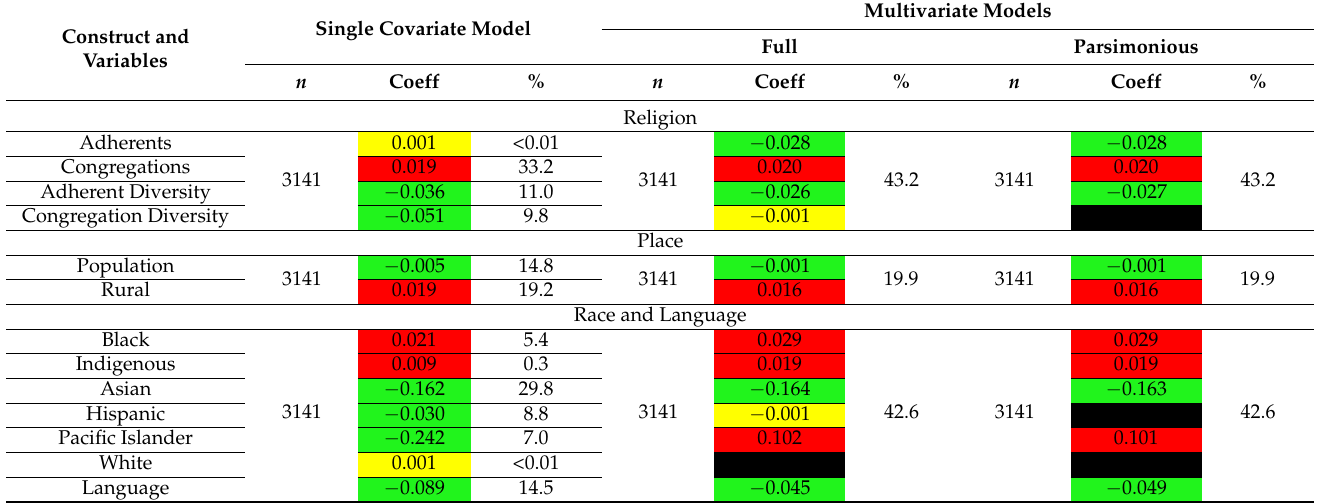
Table 3. Progression from Single Covariate to Parsimonious Multivariate Meta-Regression